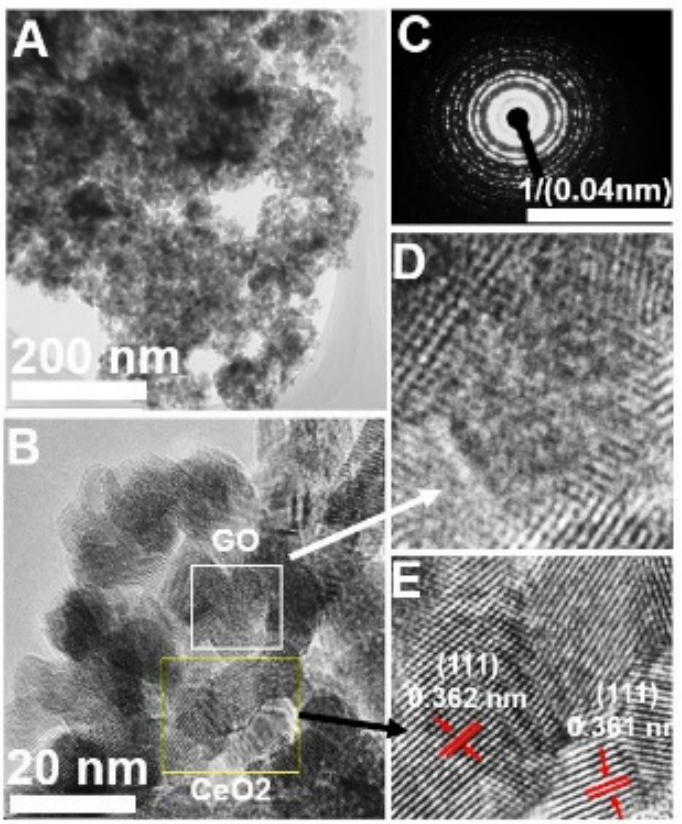
Figure 1. ( A ) TEM images of CeO 2 @GO composite; ( B ) HRTEM image shows both CeO 2 and GO region; ( C ) SAED of the CeO 2 ; ( D , E ) Enlarged HRTEM images displaying the corresponding GO and CeO 2 lattice structure in the selected area in B.